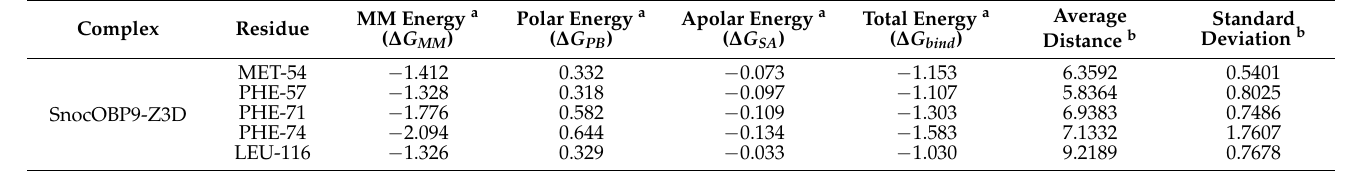
Table 6. The decomposition for the important residues contributing to the binding free energy and the average centroid distance between the five key amino acids to